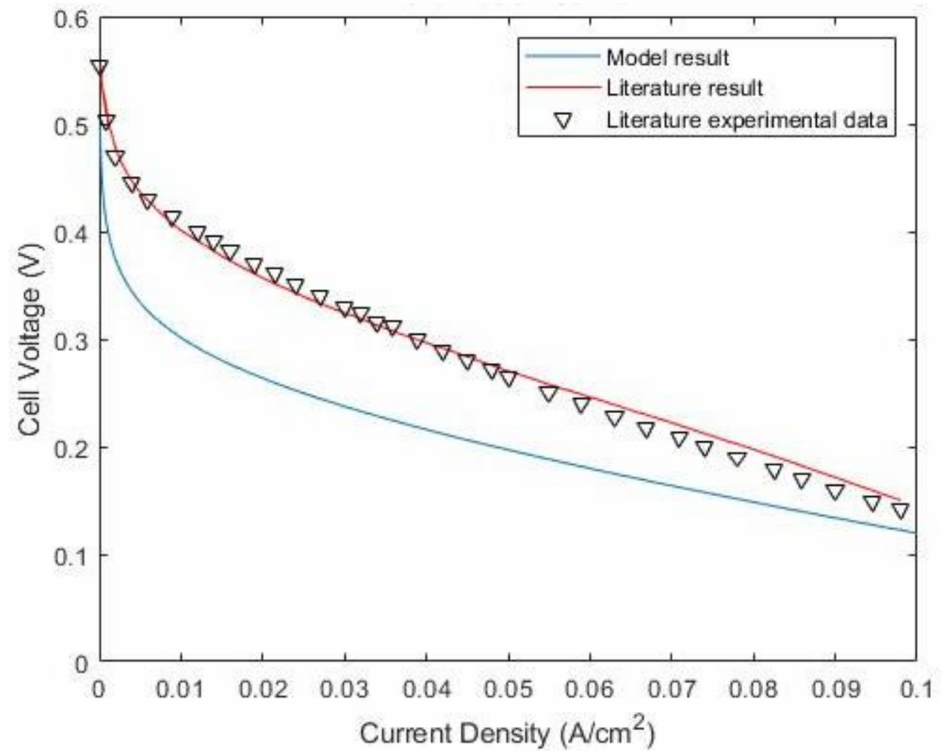
Figure 14. Polarization curve by Shrivastava et al. [36] (red line and black triangles) and the polariza- tion curve obtained from MATLAB (blue